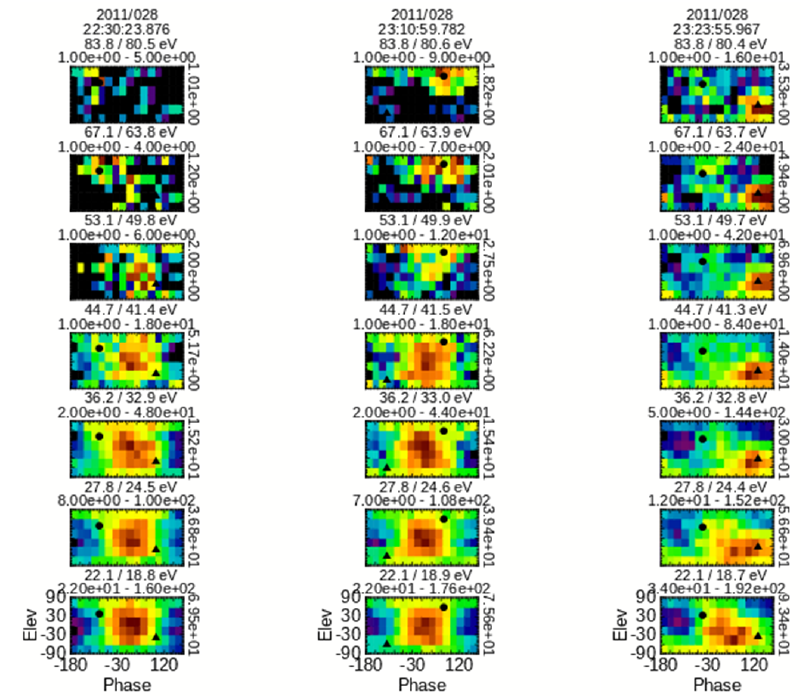
Figure 11. φ – θ plots in units of cntsacc − 1 . Each column of plots corresponds to the column of plots in Fig. 10. The plots are auto-scaled and the maximum cnt/acc scaling above each plot provides the highest count level. The value to the right of each plot is the average counts per cell in the data